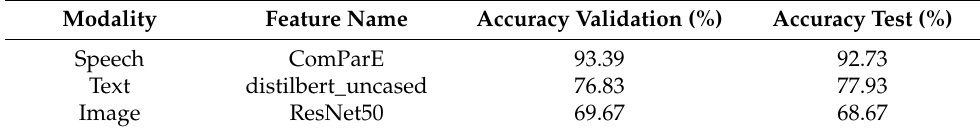
Table 5. Stage 1 results of multimodal prediction of